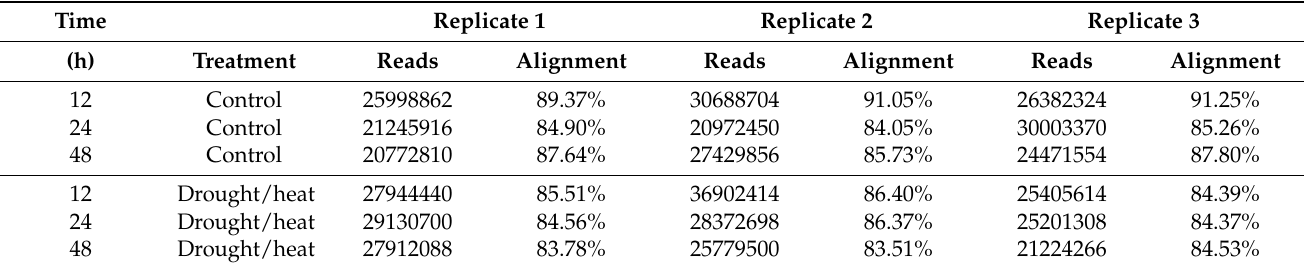
Table 1. Sequence reads (forward and reverse) and percent